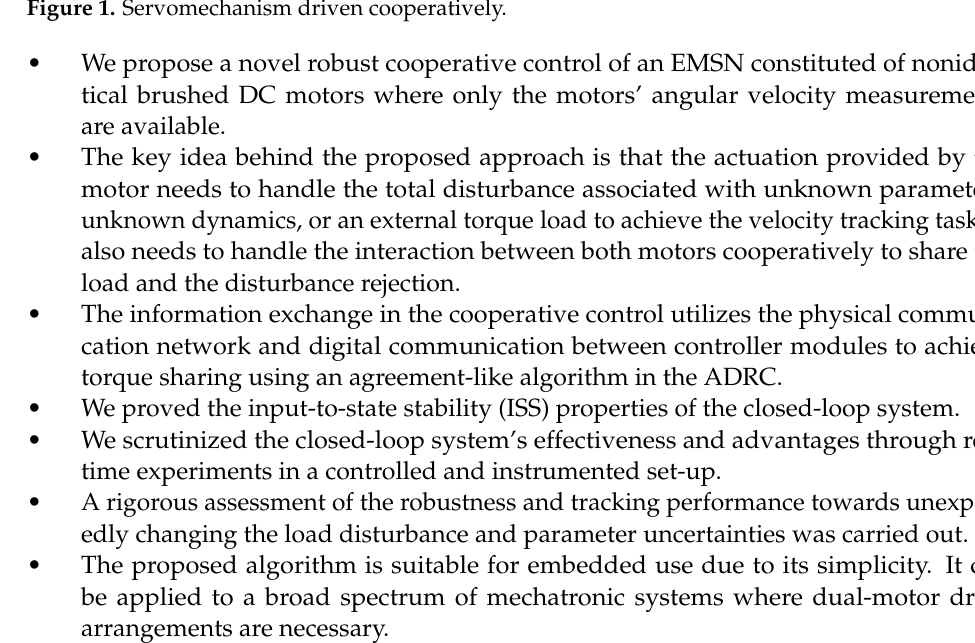
Figure 1. Servomechanism driven